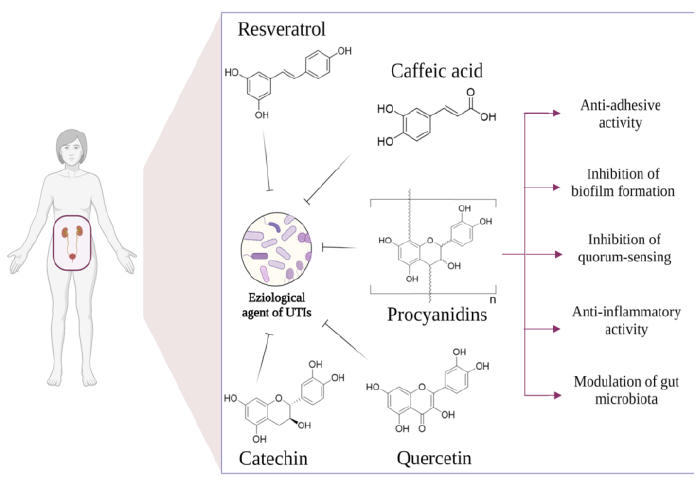
Figure 1. The main studied polyphenols and relative molecular targets for UTI prevention and